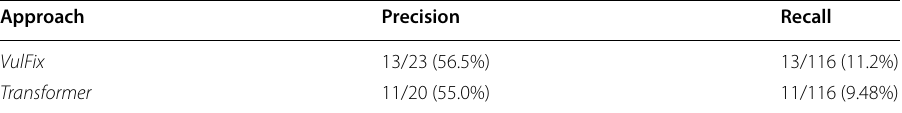
Table 2 VulRep versus Transformer vulnerability repair performance Approach Precision Recall